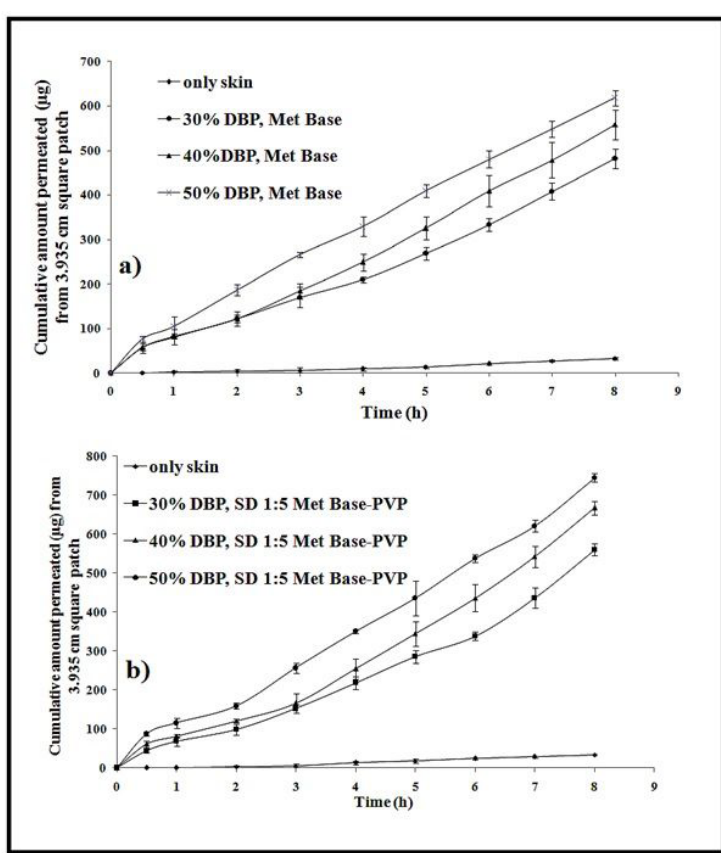
FIGURE 4 – Permeation profiles of pure Met base (a) and SD containing patches with different volume of DBP (b).